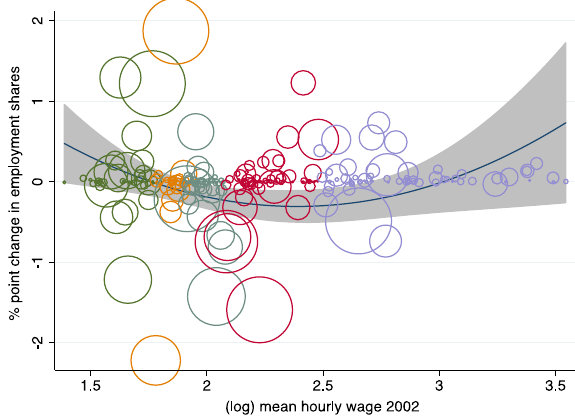
Fig. 1 Employment shares growth in Spain (1994–2014) by mean hourly wage. Notes scatter plot and quadratic prediction curve. The dimension of each circle corresponds to the number of observations within each ISCO-88 two-digit occupation and NACE.Rev.1 one-digit occupation in 1994; the grey area shows 95% confidence interval. Employment shares are measured in terms of workers. Colours represent the quintile of each job (green, first quintile; yellow, second quintile, grey, third quintile; red, fourth quintile; and violet, fifth quintile). Sources : author’s analysis from the Spanish Labour Force Survey (1994, 2014), and the Structure of Earnings Survey (2002) (color figure online)